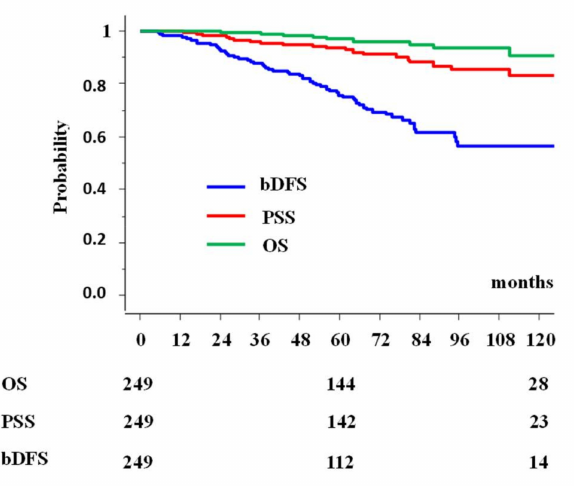
Figure 1. Biochemical disease-free rate (bDFS), prostate cancer specific survival rate (PSS), and overall survival rate (OS) in clinically T3b–T4 prostate